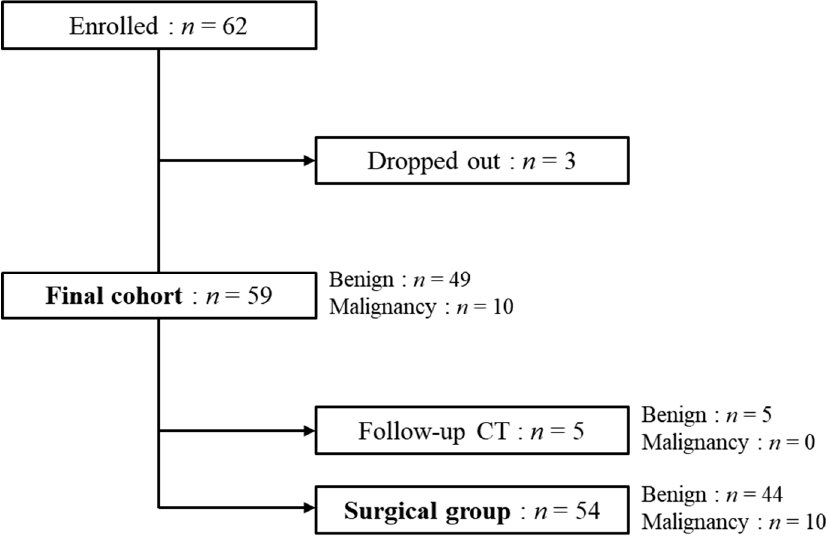
Figure 1. Flow chart of the study population.